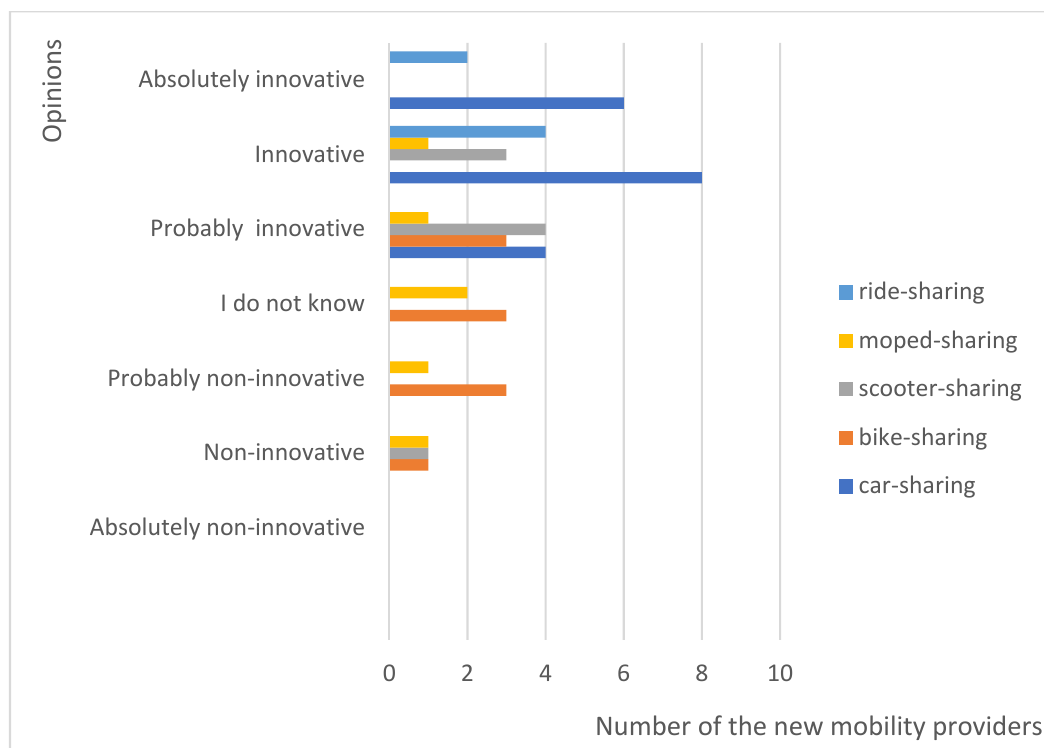
Figure 4. Innovation level of implemented practices broken down by types of service providers—detailed results broken down into new mobility sectors.